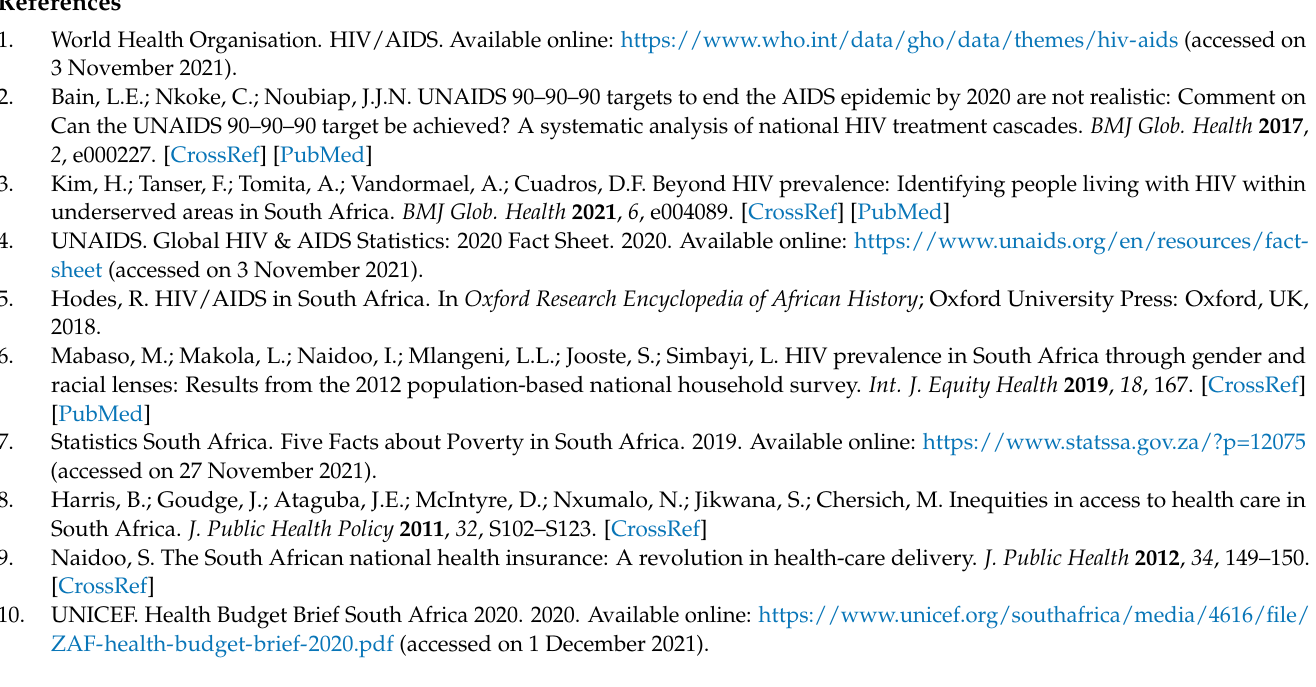
Figure A1. The process of study screening and selection, including the numbers of results from the database searches and numbers and reasons for study exclusion at each stage of the process [19].